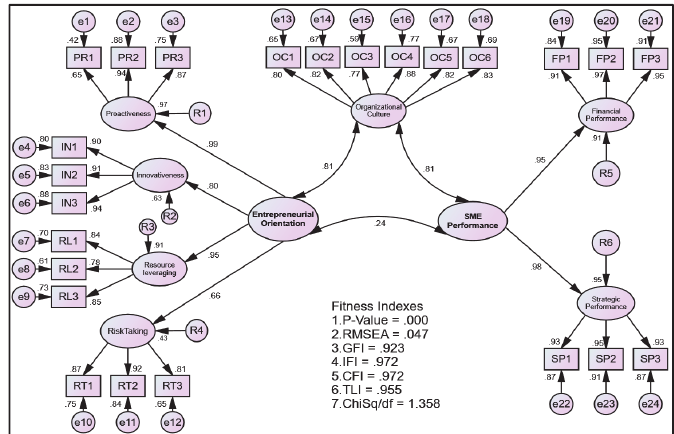
Fig. 2. Pooled CFA Output